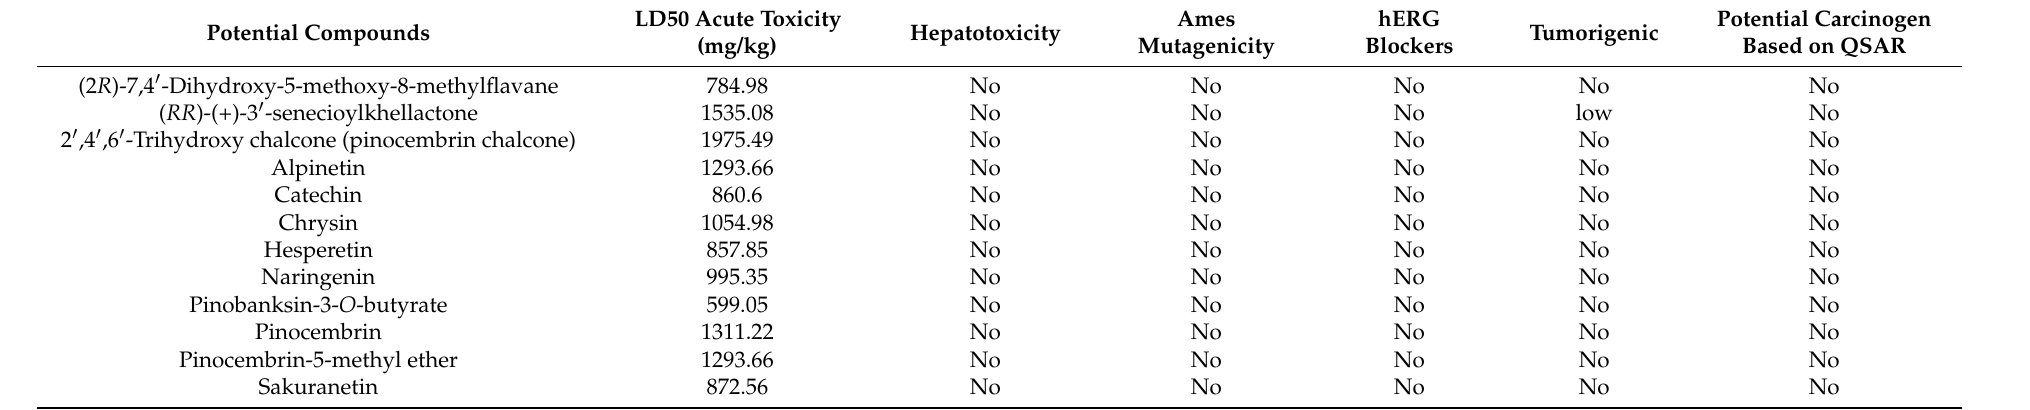
Table 6. Predicted toxicity properties of potential compounds from Asian